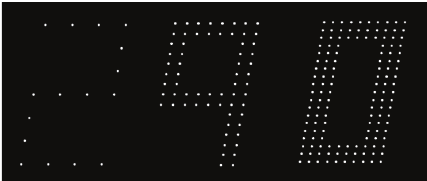
Figure 1: Examples of segmented digits defined by different num- bers of rarebits per segment (from left to right, 4, 16, and 30). For a dynamic demonstration, see ⟨ http://www.oft.gu.se/webdiagnos/ multibit/multibit.html ⟩